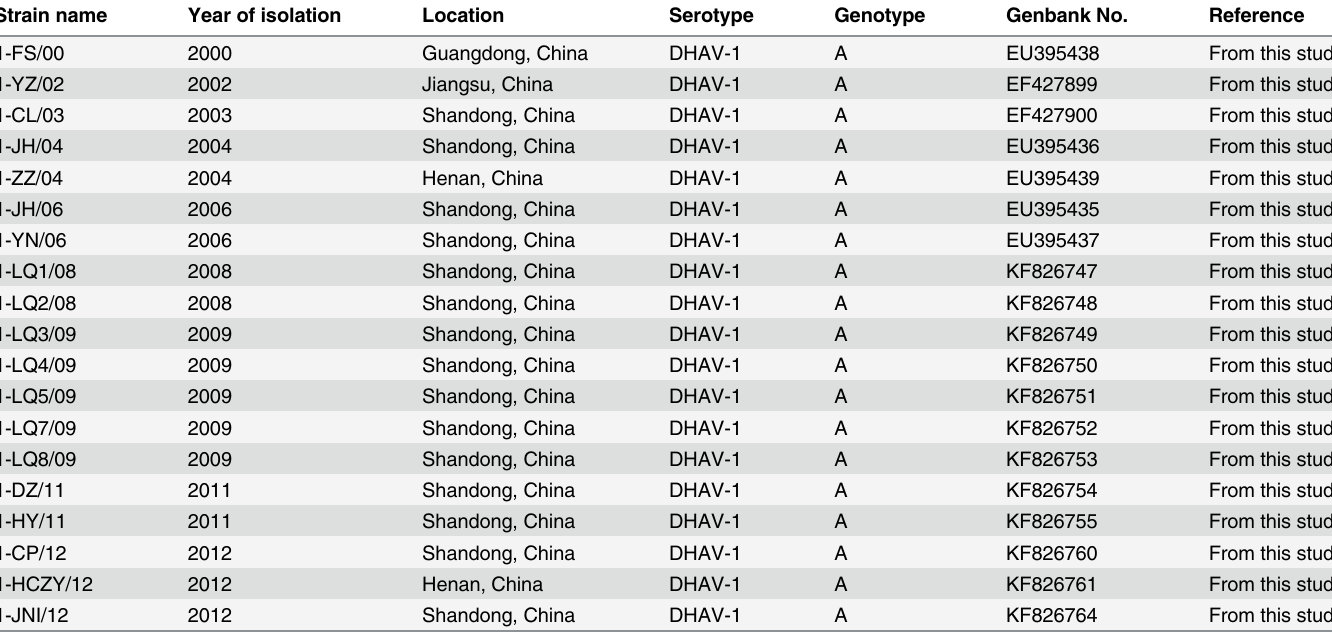
Table 1. Summary of DHAV-1 strains used in this study. Strain